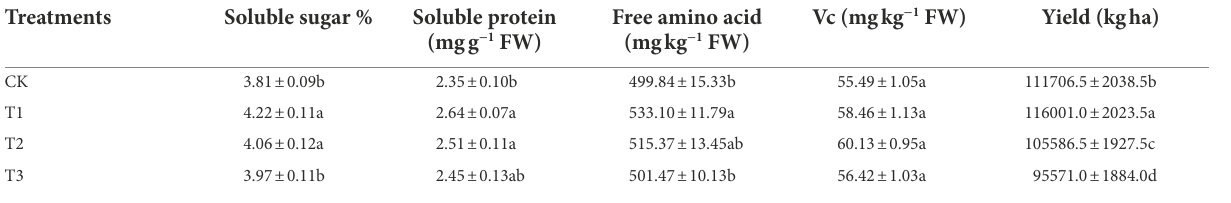
TABLE 6 Effects of different irrigation amounts on eggplant fruit quality and